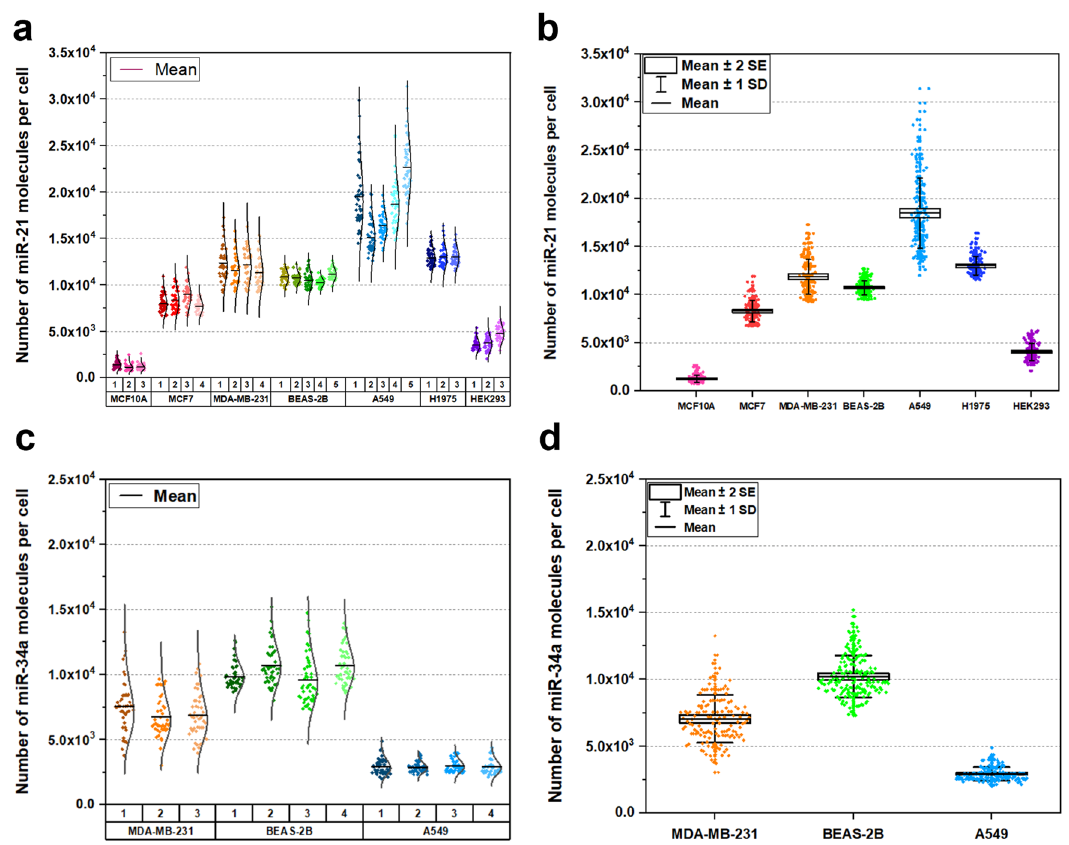
Fig. 3 Distribution of single miR-21 and miR-34a molecules expressed at a single-cell level in various cell lines. Relative single molecule count obtained from raw TIRF images were converted into absolute number of miR-21 or miR-34a molecules/cell using the corresponding calibration curves. Each data point represents the number of miRNA molecules expressed in one cell. Experimental repeats ( n ) for the same population of cells are labelled 1 – 5 ( a and d ). The black solid line indicates the mean. a Baseline expression of miR-21 in (from left to right) MCF10A (Pink; n = 3), MCF7 (Red; n = 4), MDA-MB-231 (Orange; n = 4), BEAS-2B (Green; n = 5), A549 (Light blue; n = 5), H1975 (Navy; n = 3) and HEK293 (Purple; n = 3) cells using single-cell analysis. b Box and whisker plot for miR-21 expressed in each cell line. c Baseline expression of miR-34a in MDA-MB-231 (Orange; n = 3), BEAS-2B (Green; n = 4), A549 (Light blue; n = 4) cells using single-cell analysis. d Box and whisker plot for miR-34a expressed in each cell line. Normal or gamma distribution curves were used to fi t the data to highlight the shape of each